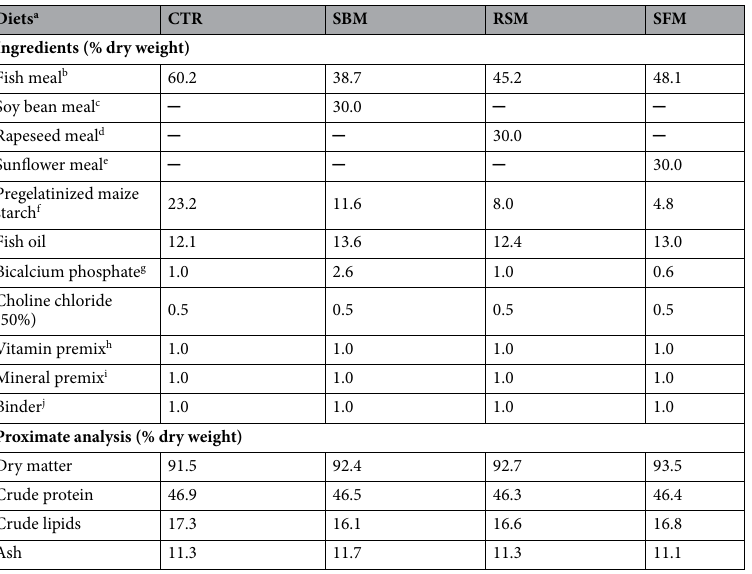
Table 3. Ingredients composition and proximate analysis of experimental diets. DM dry matter, CP crude protein, CL crude lipid. a CTR, control fishmeal based diet; SBM, soybean meal based diet; RSM, rapeseed meal based diet; SFM, sunflower meal based diet. b Steam Dried LT fish meal, Pesquera Diamante, Austral Group, S.A Perú (CP: 74.7% DM; GL: 9.8% DM). c Sorgal, S.A. Ovar, Portugal (CP: 53.7% DM; GL: 2.1% DM). d Sorgal, S.A. Ovar, Portugal (CP: 37.5% DM; GL: 4.0% DM). e Sorgal, S.A. Ovar, Portugal (CP: 30.3% DM; GL: 1.0% DM). f C-Gel Instant-12016, Cerestar, Mechelen, Belgium. g Premix, Portugal (Calcium: 24%; Total phosphorus: 18%). h Vitamins (mg kg −1 diet): retinol acetate, 18,000 (IU kg −1 diet); cholecalciferol, 2000